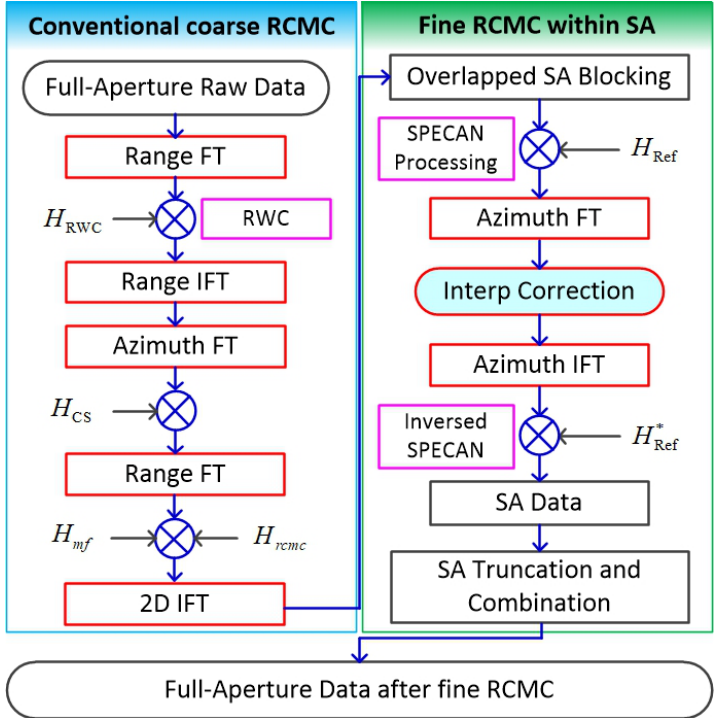
Figure 1. Flowchart of the proposed range cell migration correction (RCMC) method for highly squinted synthetic aperture radar